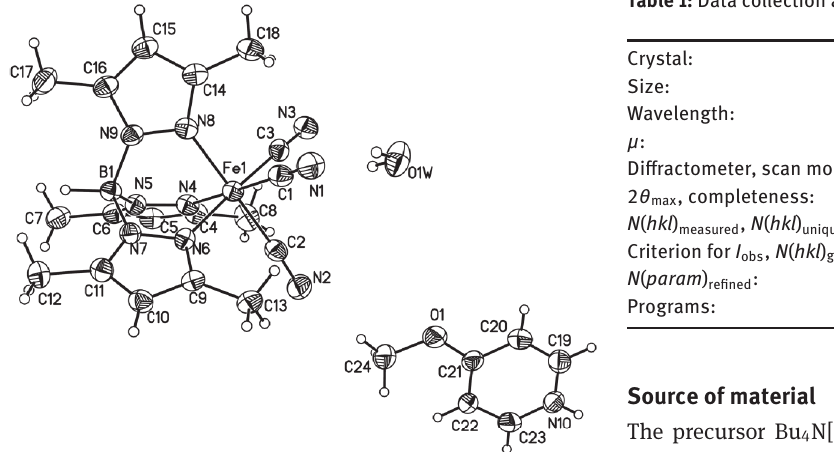
Table 1: Data collection and